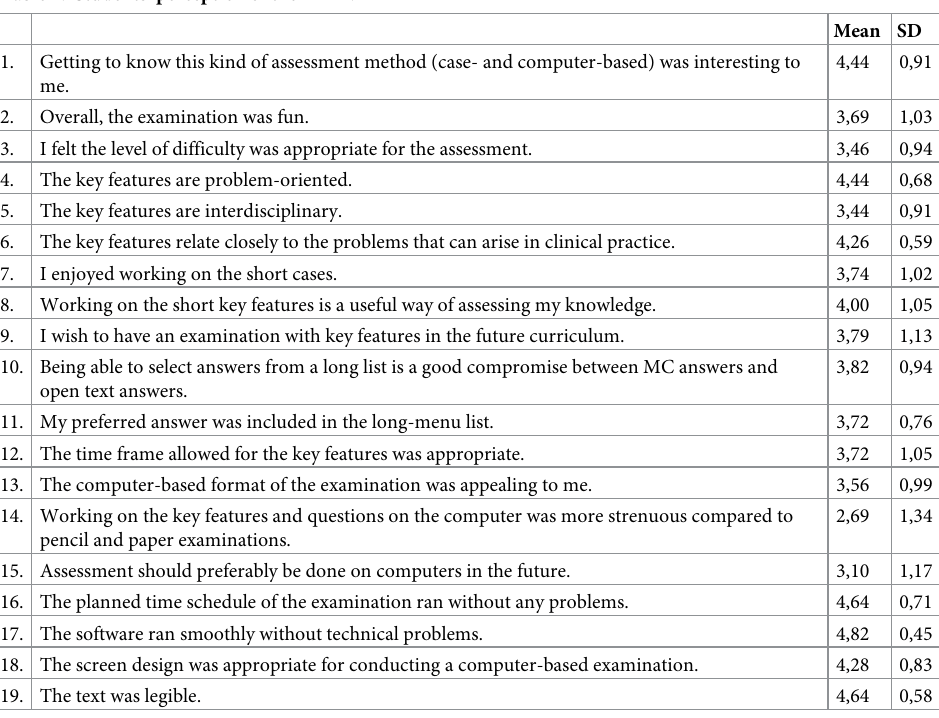
Table 2. Students’ perception of the